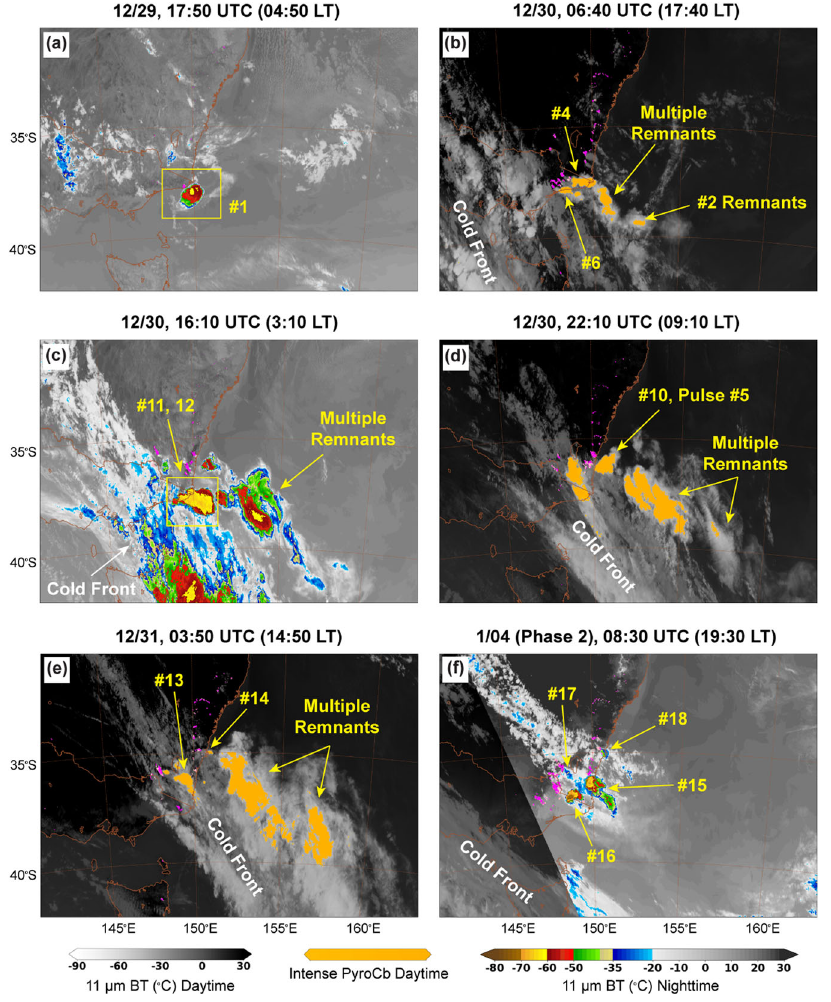
Fig. 5 Key stages of ANYSO pyroCb activity observed from satellite. Grayscale shading indicates daytime BT 11 from AHI, with colder, high- altitude cloud tops displayed in white. Orange shading coincides with smoke-perturbed pyroCb cloud tops. Multi-color shading indicates nighttime BT 11 , with high-altitude cloud tops displayed in red, yellow, and brown (e.g., #16). PyroCb sub-event numbers match those in Figs. 1 and 4, with a – e highlighting sub-events observed during ANYSO ’ s fi rst phase and f highlighting peak activity during phase two. AHI pixels with active fi res are displayed in pink. The approximate position of an approaching surface cold front is denoted in white. Animations of this imagery are provided in Supplementary Information for both ANYSO